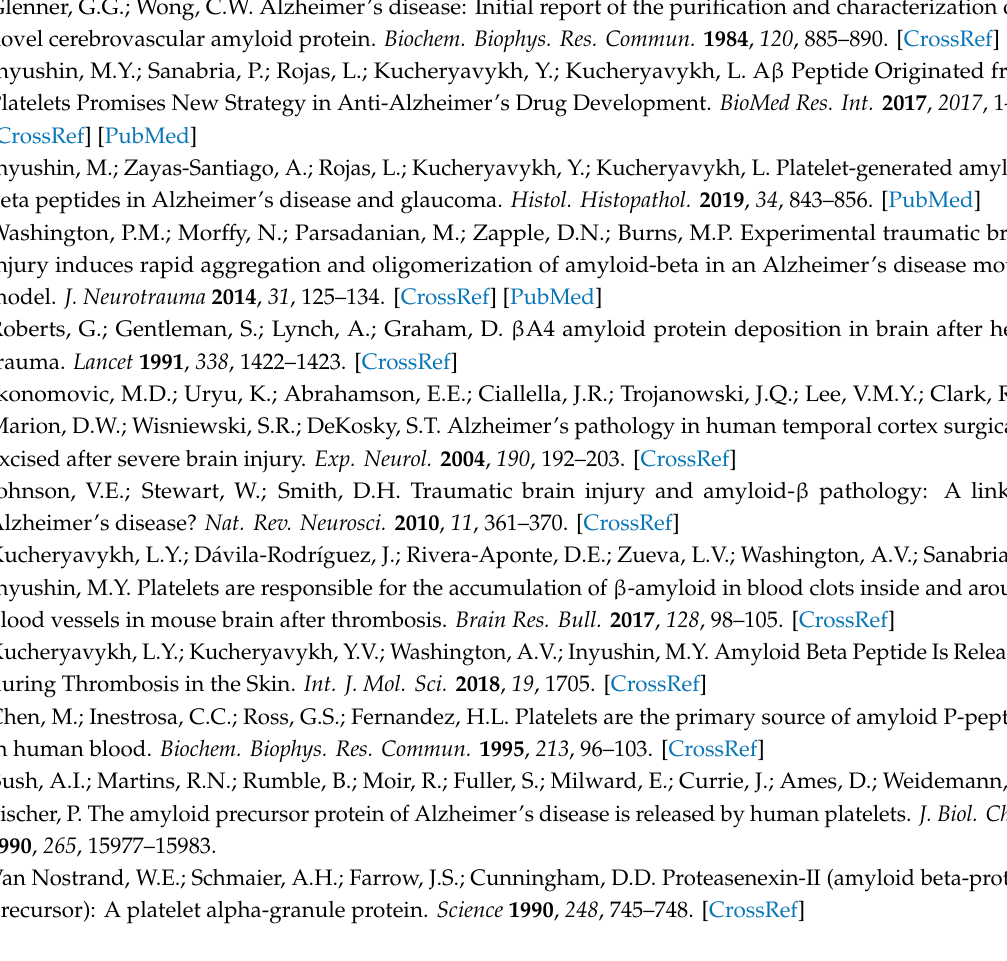
3D movie of Figure 2A panel